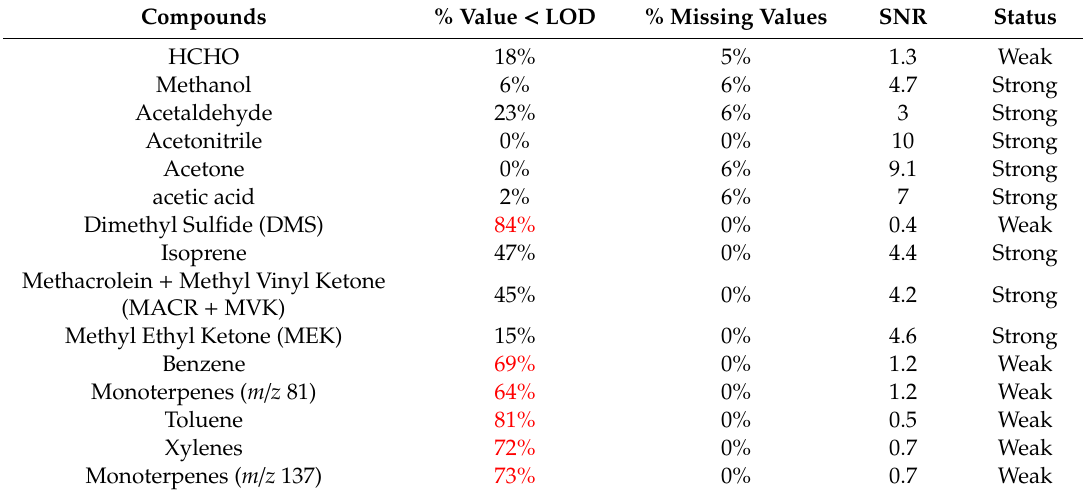
Table 2. Summary of data quality: percentage of values below the limit of detection (LOD), percentage of missing values, signal to noise ratio (SNR), and status attributed at the volatile organic compounds (VOCs) for the positive matrix factorization (PMF) analysis. The red values show the importance of the percentage of values below the LOD and missing